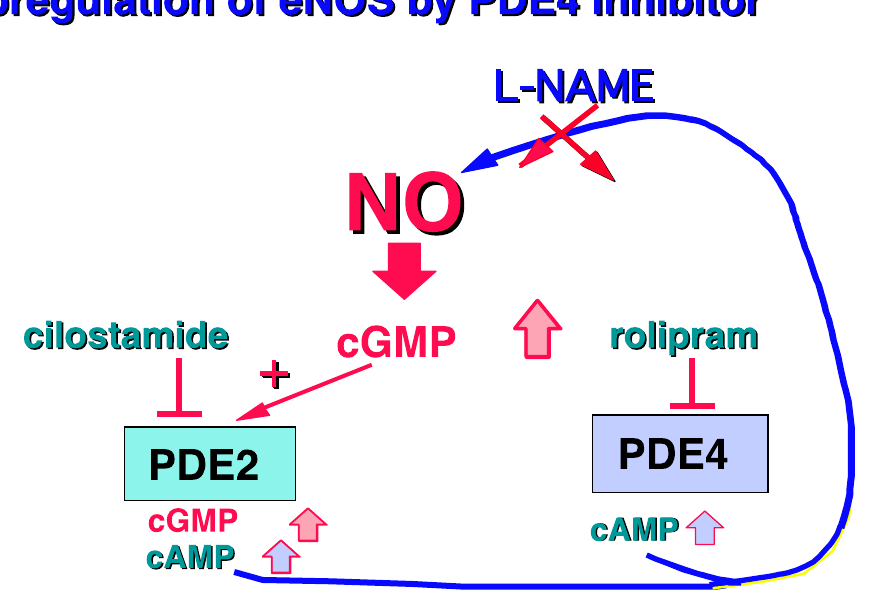
Figure 6. Increase in cGMP in human endothelial cells related to PDE4 inhibition [47].